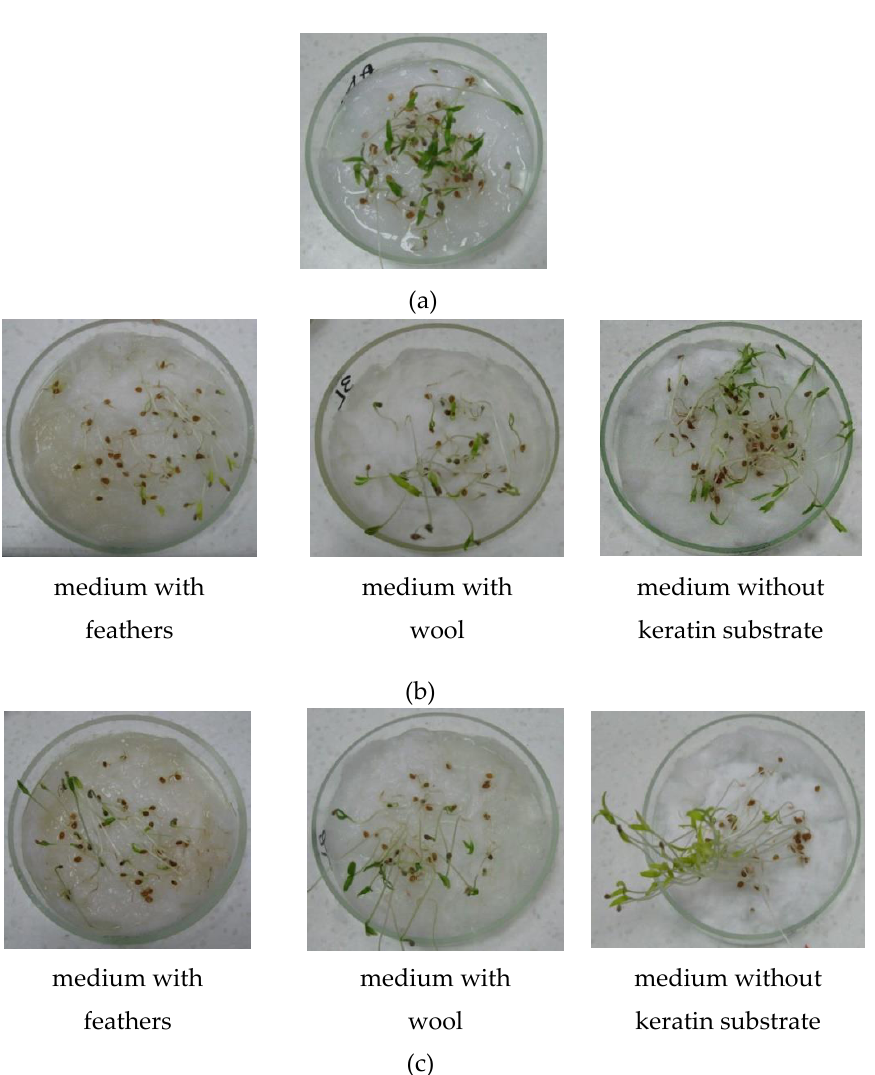
Figure 5. Germination of tomato seeds under treatment with protein hydrolysates PHs from Trichoderma isolates grown on different culture media. ( a ) application of water (control). ( b ) application of PHs from T. asperellum. ( c ) application of PHs from T. atroviride .